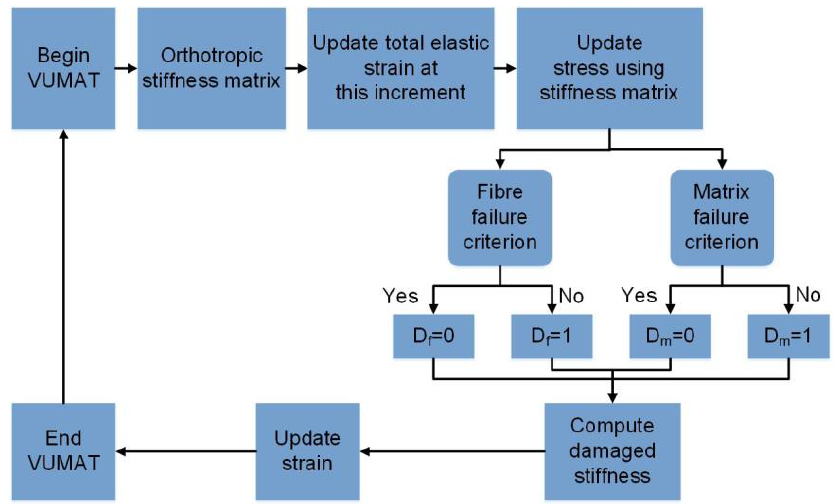
Figure 5. Implementation of the damage evolution model using VUMAT subroutine in ABAQUS.